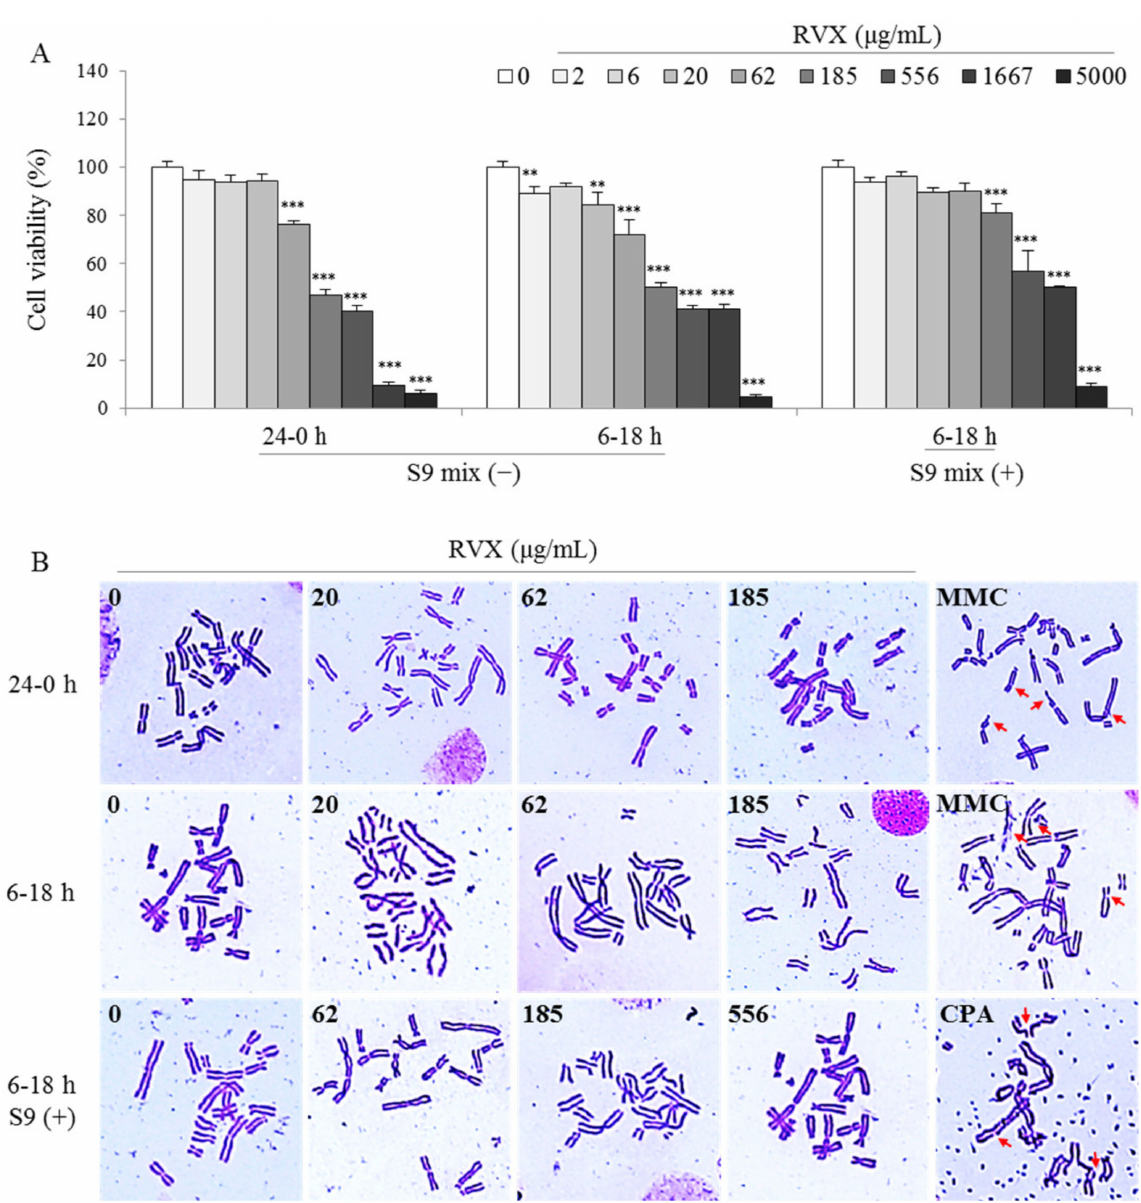
Figure 3. ( A ) Chinese hamster ovary cell line (CHO-K1) cell viability was determined using a 3-(4,5-dimethylthiazol-2-yl)- 2,5-diphenyltetra-zolium bromide (MTT) assay. ( B ) Chromosomal aberration CHO-K1 cells were treated RVX or MMC for 24 h for long-term treatment, while cells were treated with RVX or MMC for 6 h, followed by incubation in fresh media for a further 18 h, under the two conditions (absence or presence of the S9 mix) for the short-term treatment. The structural and numerical chromosomal aberrations were counted under an optical microscope. ** p < 0.01 and *** p < 0.001 compared to the negative control (0 µ g/mL). MMC, Mitomycin